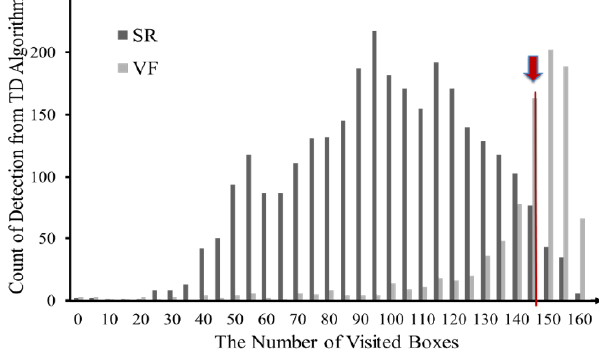
Figure 10. Probability histogram for deciding the parameter of TD within CU database.